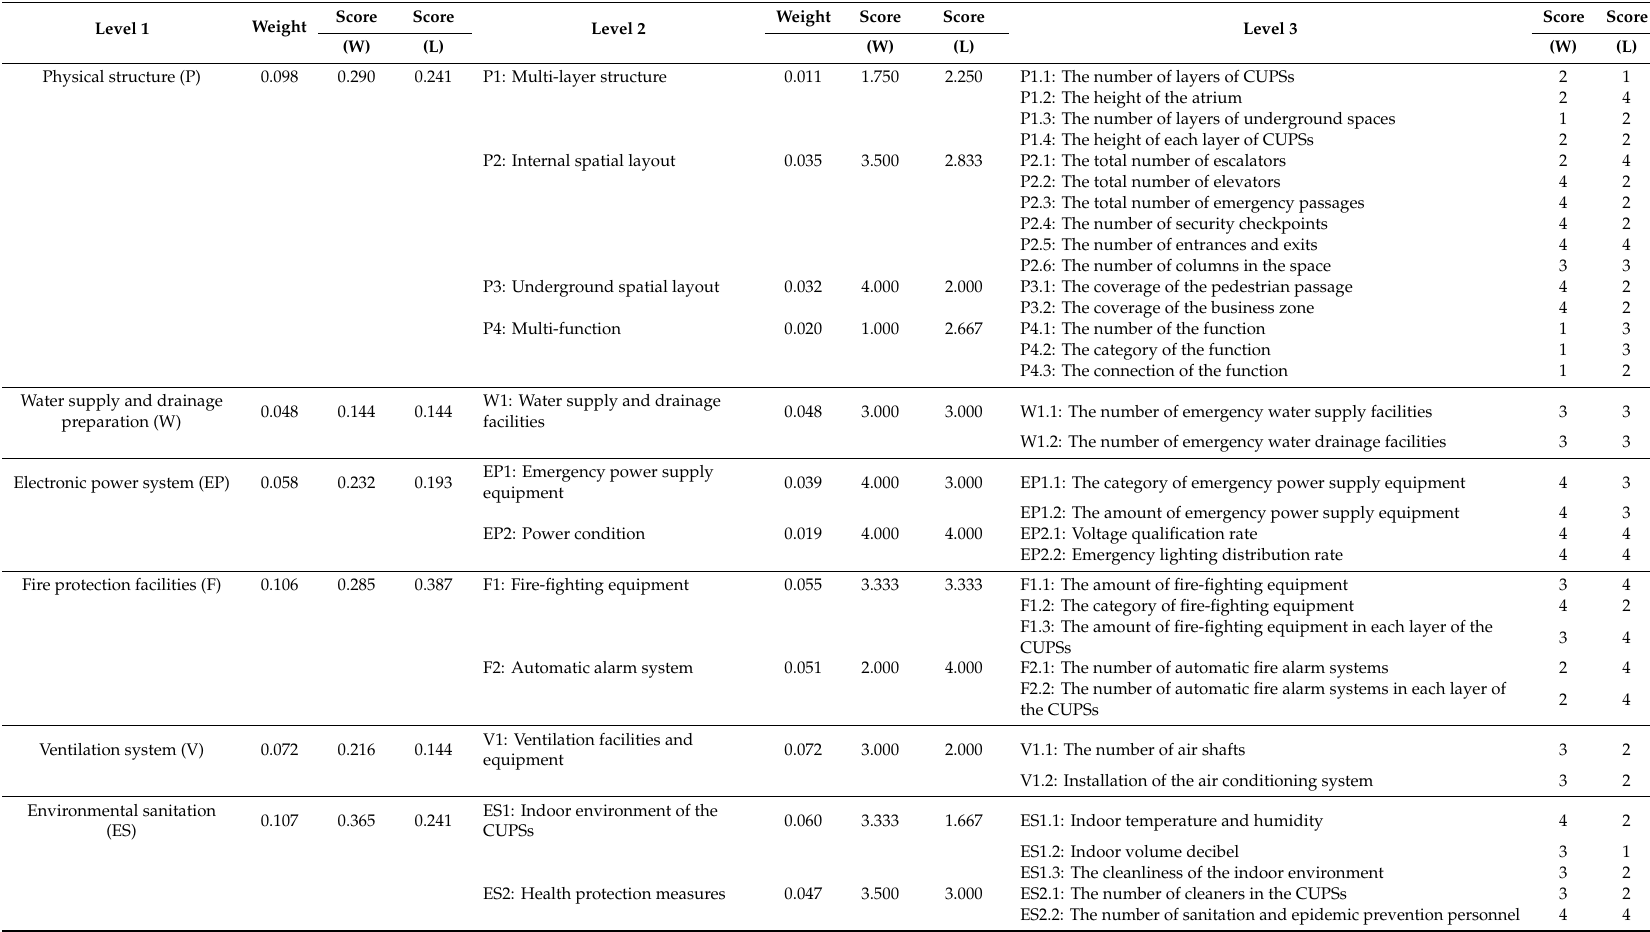
Table 2. The indicator system of